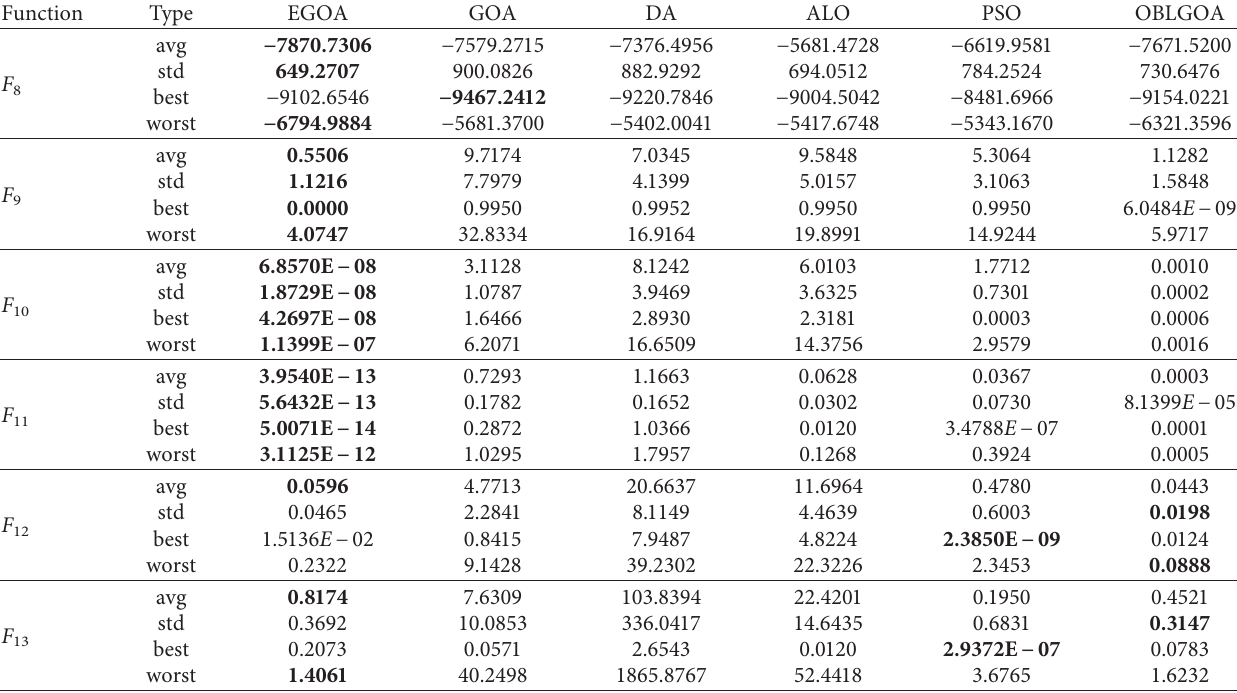
Table 5: Results for multimodal